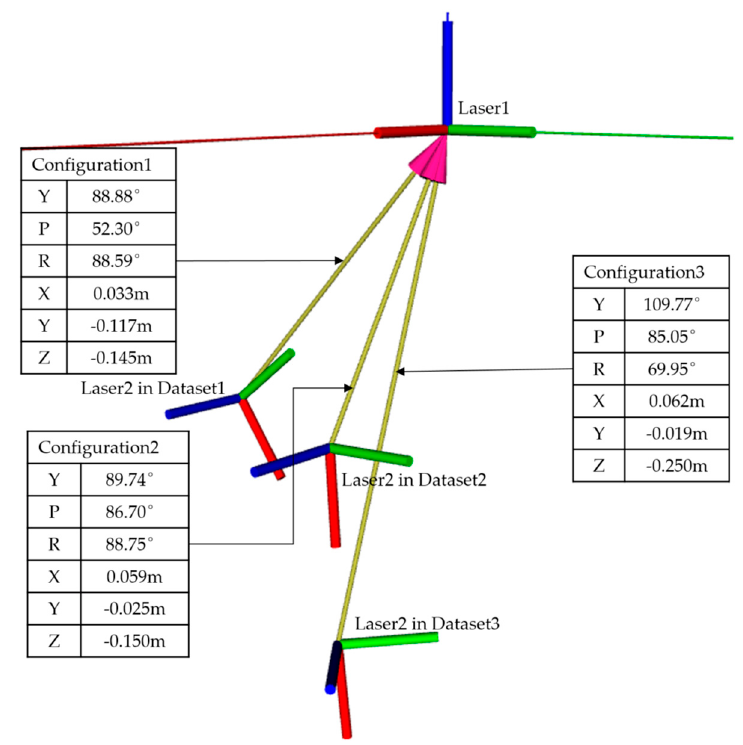
Figure 11. The laser frame configurations corresponding to the calculated transformation parameters in three different datasets, which is defined by a six dimensional vector including Euler extrinsic rotation angles YPR around a fixed Z - Y - X (blue-green-red) axis and the translation. Table 4. Orientation accuracies of the training points and test points in the three datasets.